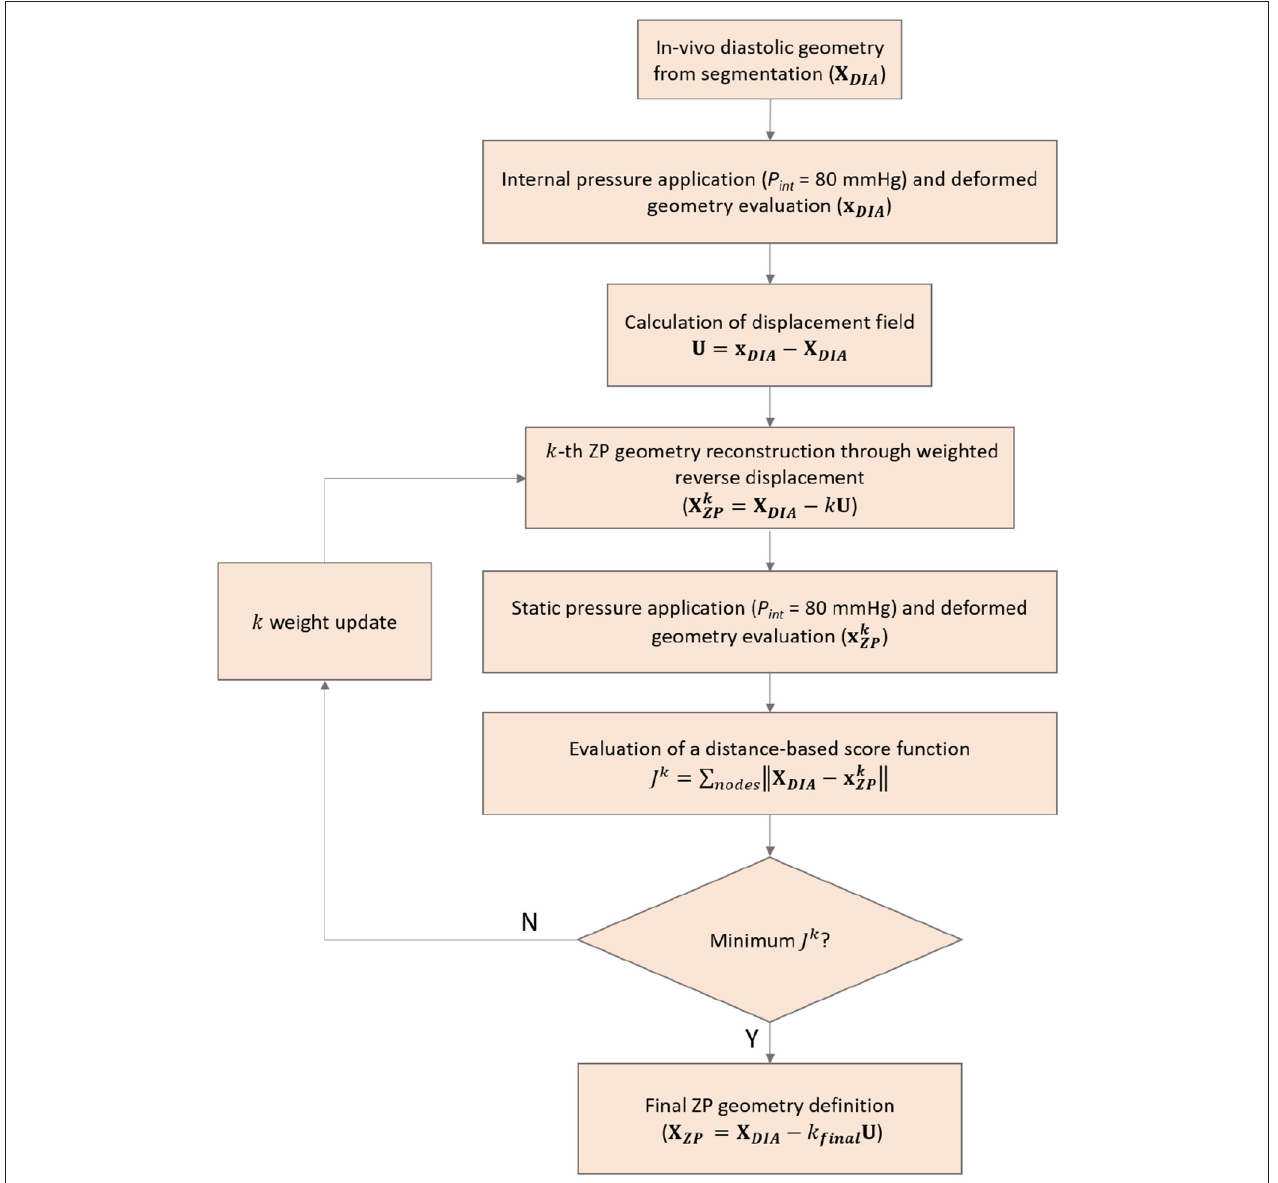
FIGURE 2 | Schematic of the reverse displacement algorithm used for the ZP geometry